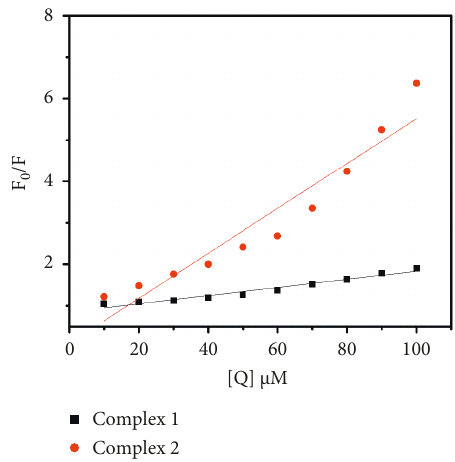
Figure 8: Stern–Volmer plots of complexes 1 and 2